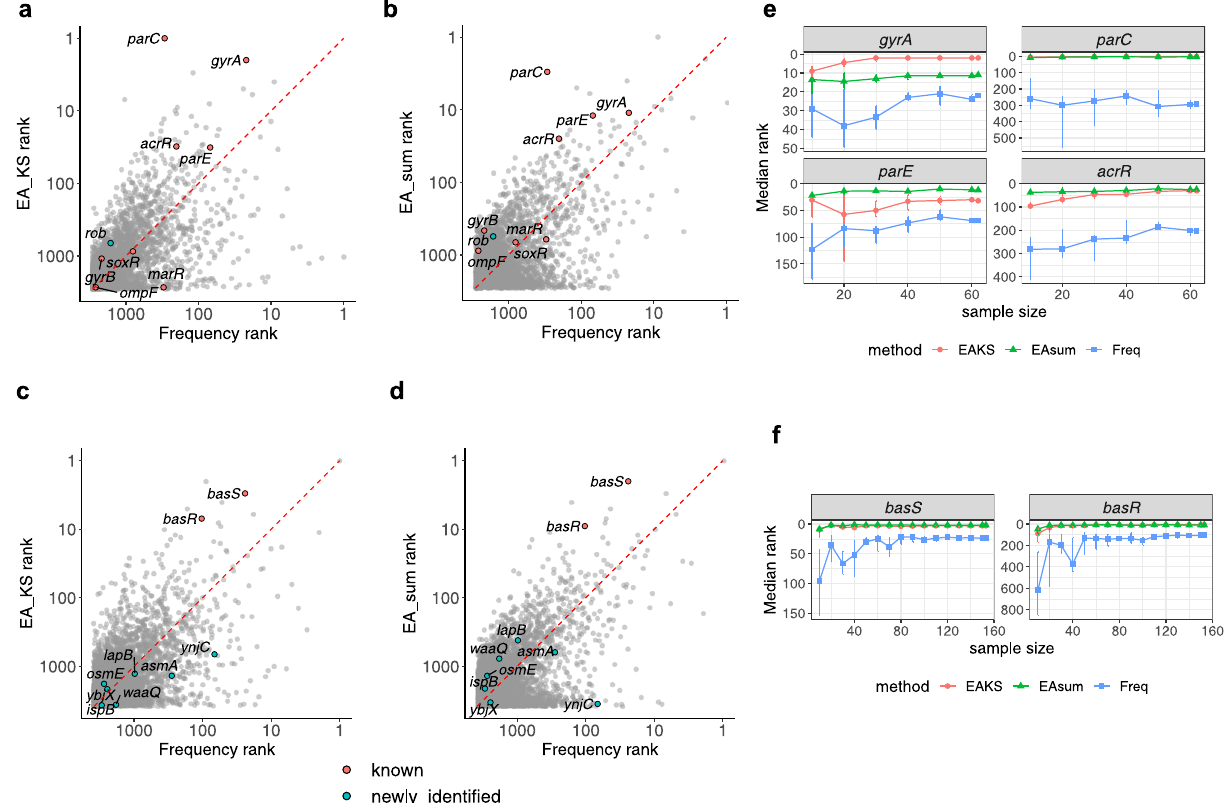
Fig. 4 Comparisons of EA integration with frequency-based analysis in clinical/environmental datasets. Frequency analysis and EA integration ranks (EA-KS and EA-sum) of the mutated genes in cipro fl oxacin resistant ( a , b ) and colistin resistant ( c , d ) clinical/environmental strains. Known drivers (orange) and genes with mutations that contribute to fi tness in the presence of antibiotic (cyan) are highlighted. Median rank of cipro fl oxacin resistance driver gene ranks ( e ) and colistin resistance driver gene ranks ( f ) in down-sampling analysis wherein random subsets of the samples were chosen for analysis by EA-KS (red/circles), EA-sum (green/triangles) or frequency (blue/squares). Interquartile range is displayed as error bars from 10 independent random draws at the indicated sample size. Source data are provided as a Source Data fi